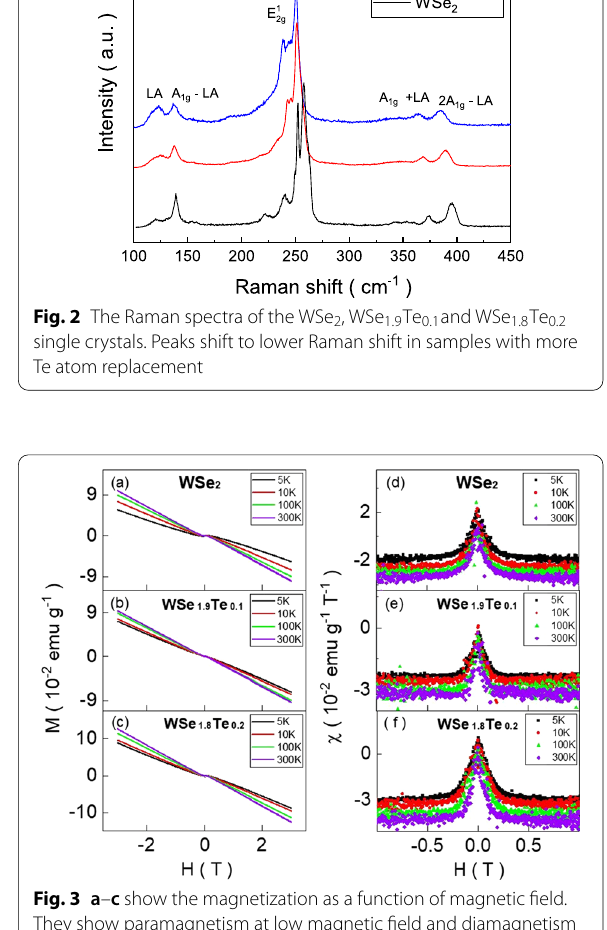
magnetic field. It shows paramagnetism behavior at low magnetic field and diamagnetism at high magnetic field. The diamagnetism is negatively proportional to mag- netic field at high magnetic field, and smaller suscepti- bility is observed at higher temperatures. Figure 3d–f shows the susceptibility as a function of magnetic field, and it reveals a paramagnetic-like peak at H peak values are of weak temperature dependence. This paramagnetic-like susceptibility peak at H speculated to originate from the spin texture at the Dirac point of surface state in topological materials [1–6]. The carrier spin couples to the carrier momentum and that